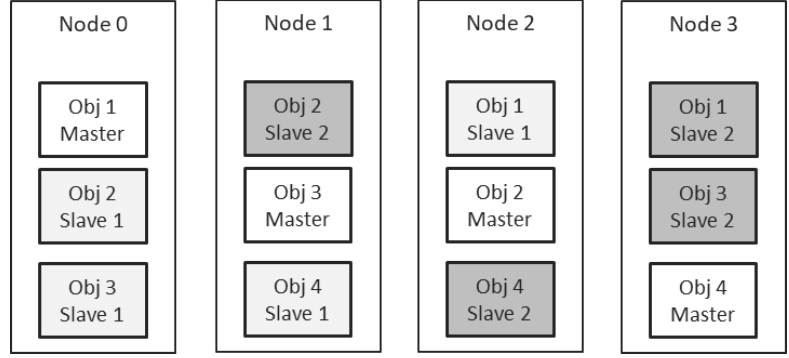
Figure 10. Partitioning and Replication in a DOORS instance.